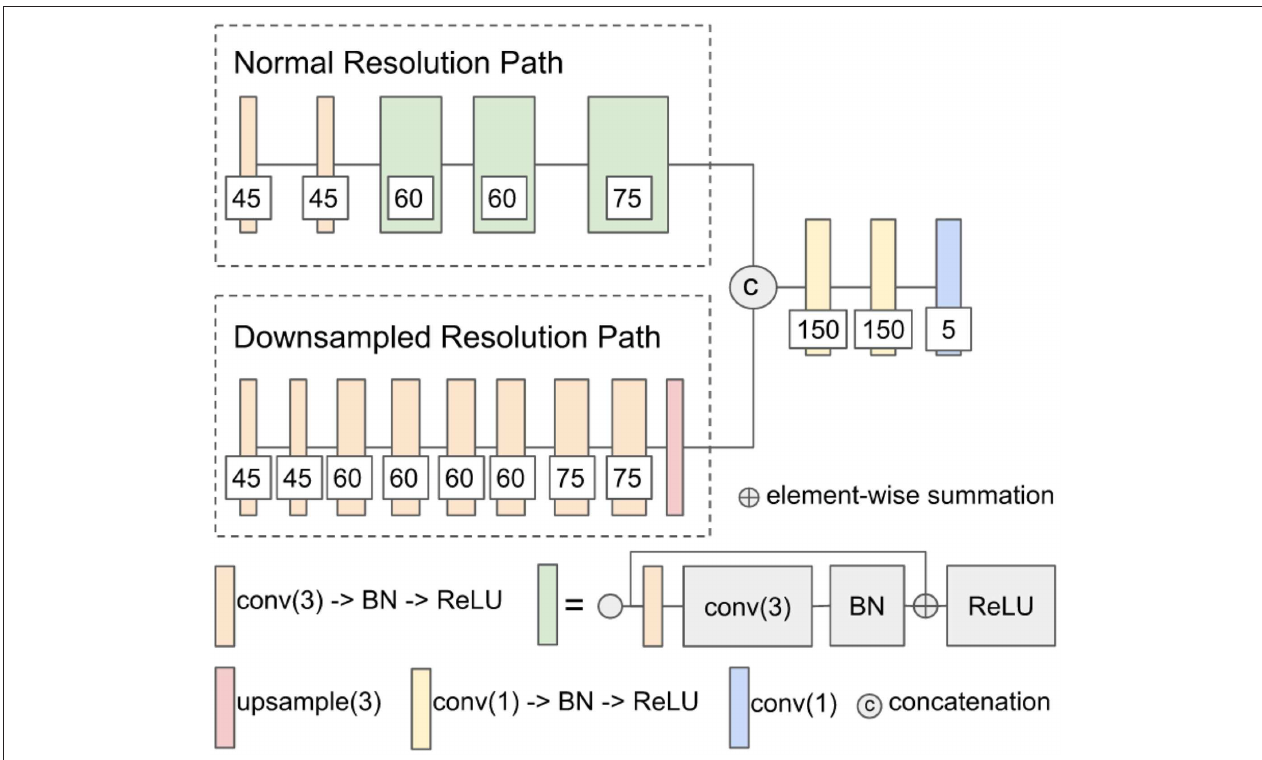
FIGURE 1 | The network architecture of modified DeepMedic. conv(3), 3 × 3 × 3 convolutional layer; BN, batch normalization; upsample(3), trilinear interpolation by a factor of 3; and conv(1), 1 × 1 × 1 convolutional layer.